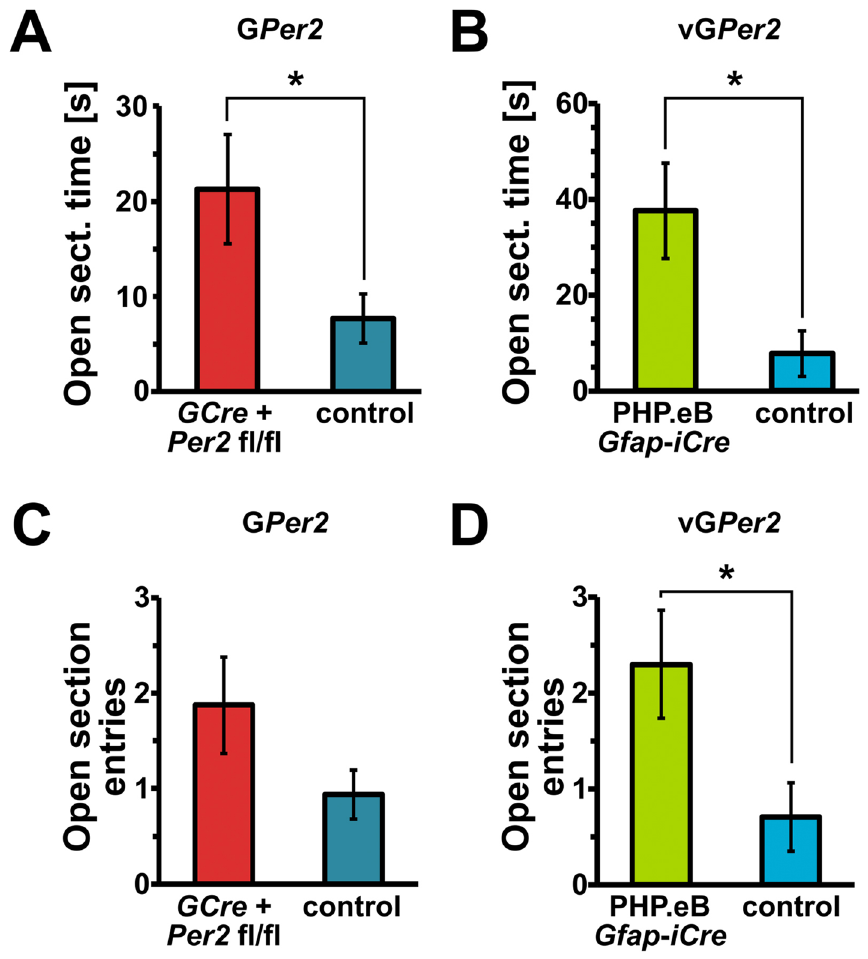
Figure 3. Reduced anxiety of G Per2 and vG Per2 animals in the elevated O-maze. ( A ) Time spent in the open area of the O-maze is longer in G Per2 ( GCre + Per2 fl/fl , red) animals compared to controls (blue) (n = 16 and 18, respectively, two-tailed t-test, * P < 0.05). ( B ) Time spent in the open area of the O-maze is significantly longer in vG Per2 (AAV-PHP.eB Gfap-iCre , green) compared to controls (blue) (n = 6 and 7, respectively, two-tailed t-test, * P < 0.05). ( C ) Entries into the open section of the O-maze are not significantly different between the G Per2 animals (red) and their controls (blue) (n = 16 and 18, respectively, two-tailed t-test, P = 0.15). ( D ) The number of entries into the open section of the O-maze is higher in vG Per2 animals (green) compared to their controls (blue) (n = 6 and 7, respectively, two-tailed t-test, * P <